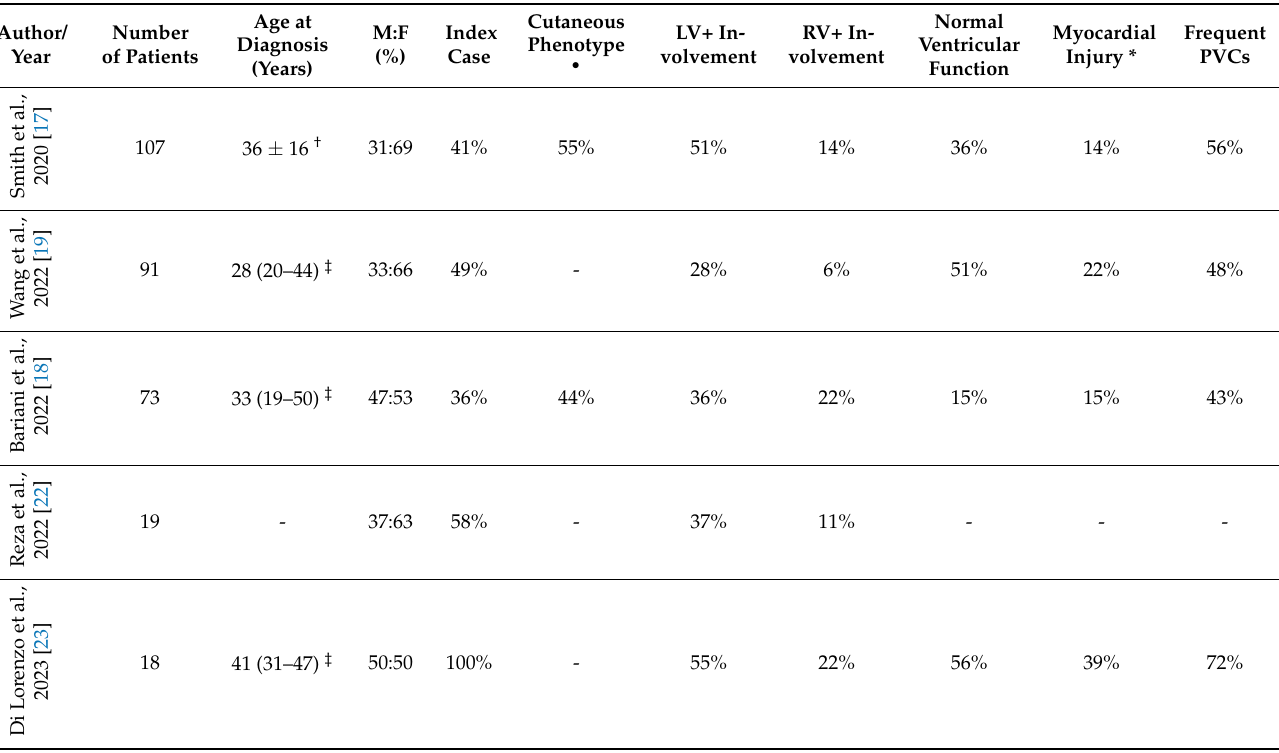
Table 1. Baseline characteristics of patients with DSP